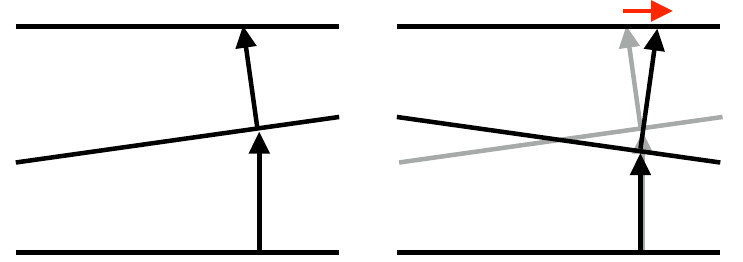
Figure 2 . Slicing transformations, t t + f ( x A ), do not commute. After a slicing transforma- ! tion, the normal of the new spatial slice is tilted. The commutator of two in(cid:12)nitesimal slicing transformations is a spatial